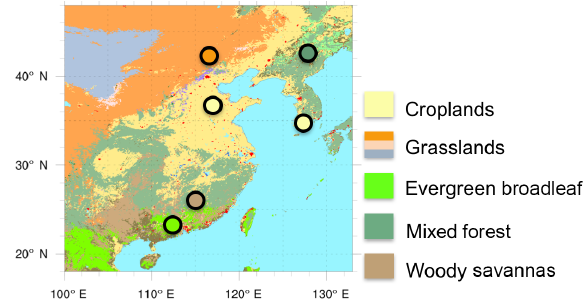
Figure 1. Dominant IGBP categories from MOD12Q1 data over the study domain. Circled points represent approximate location and IGBP class of eddy flux sites used in VPRM-CHINA